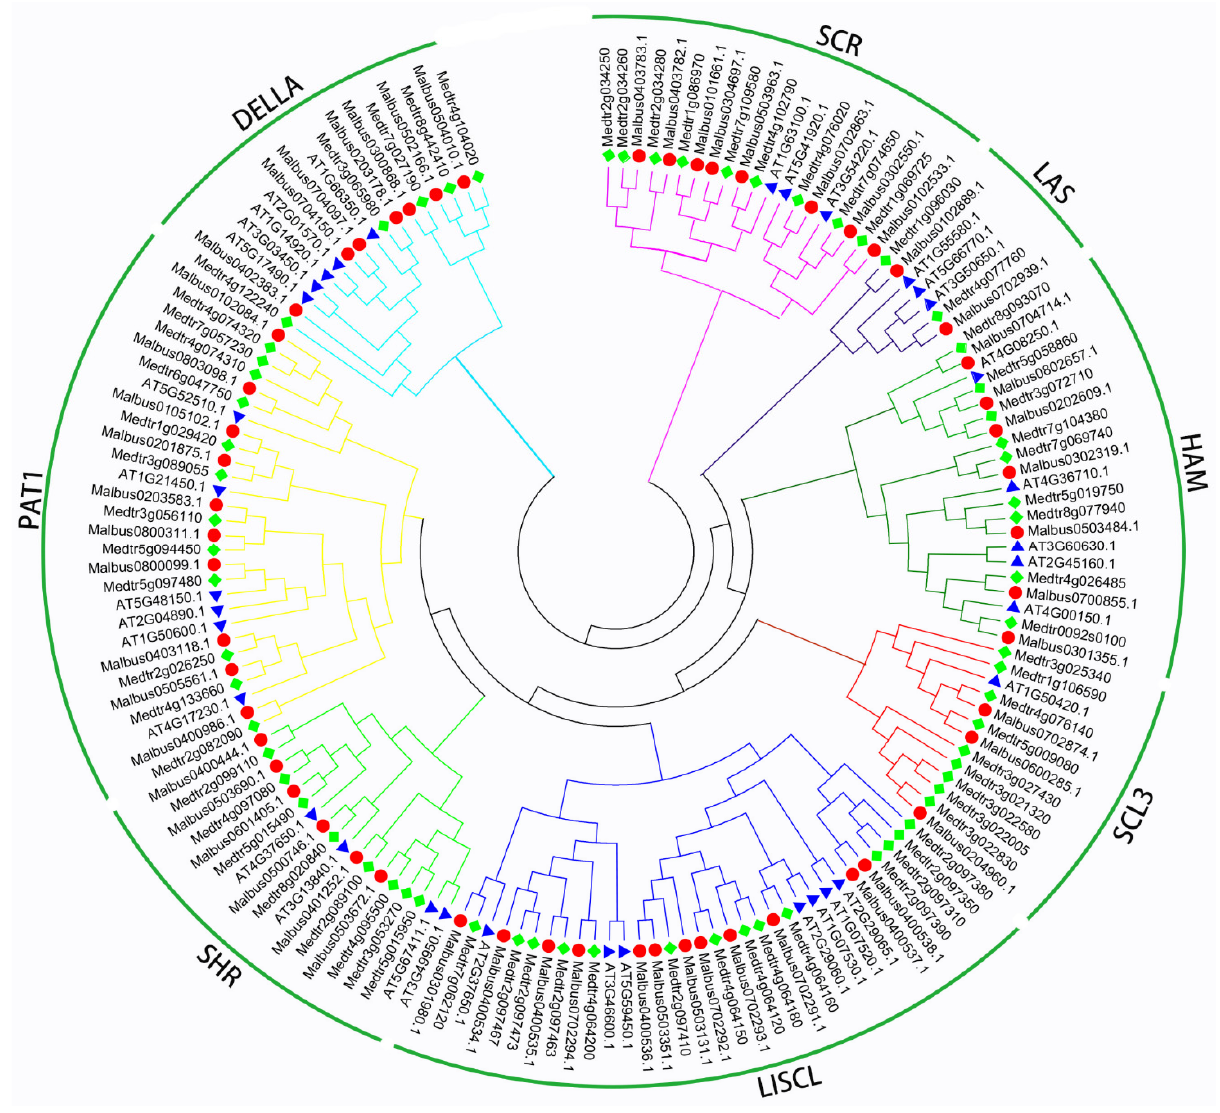
Figure 1. Phylogenetic tree constructed using GRAS proteins from M. albus (red circle), M. truncatula (green square) and A. thaliana (blue triangle). The phylogenetic tree was constructed using MEGA 7.0 and using the neighbor − joining method.